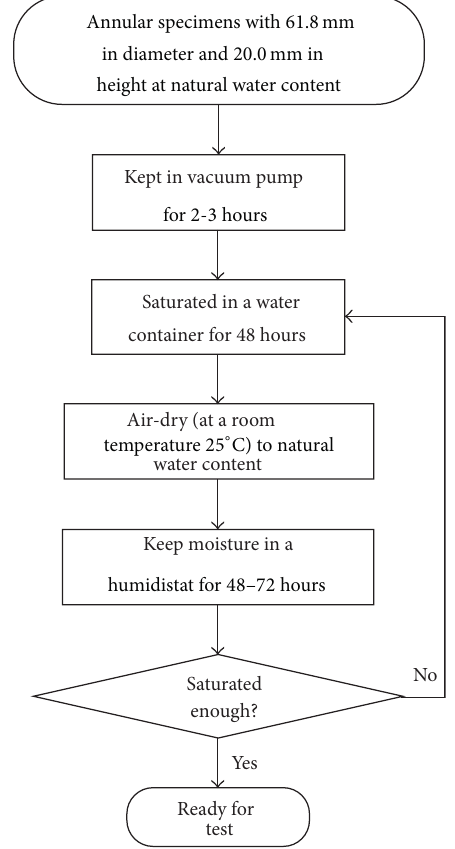
Figure 5: Flowchart of the wet-dry